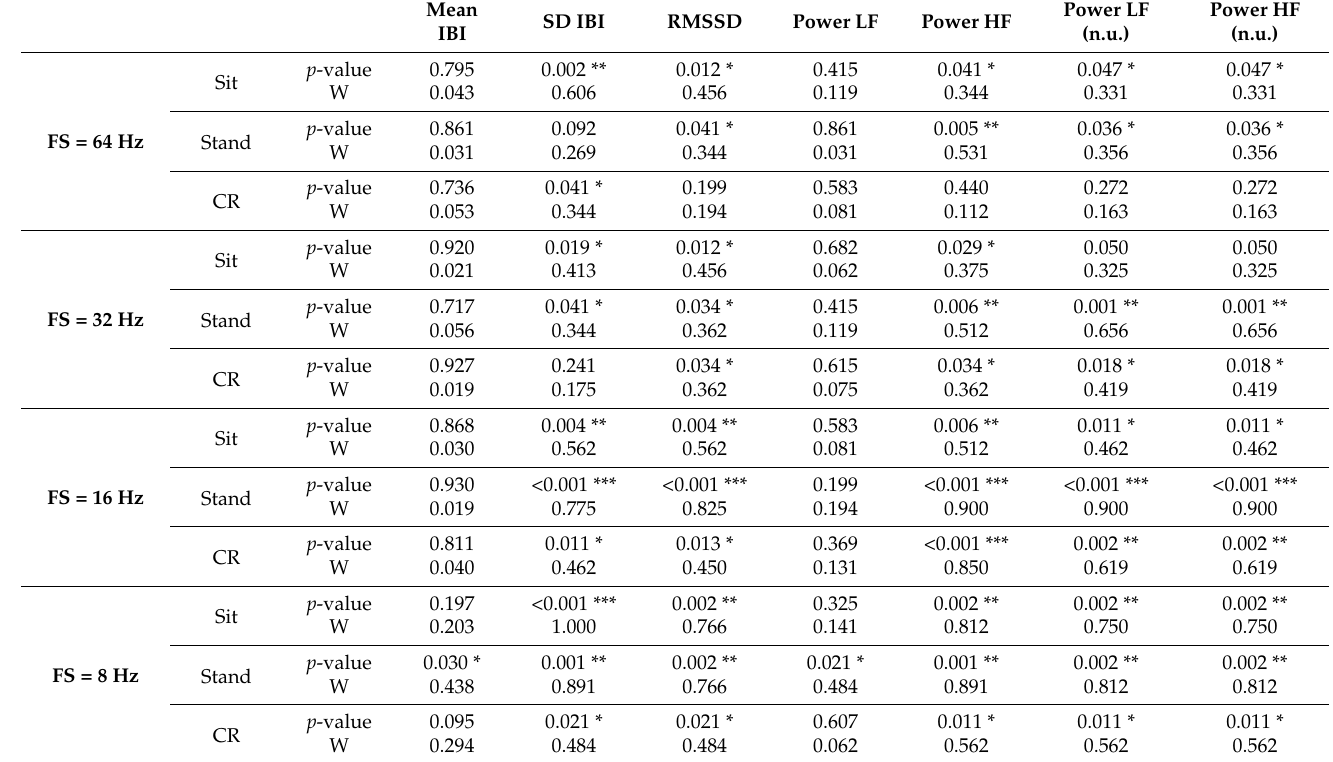
Table 6. Comparison of the HRV indices estimated with the different PPG interpolation techniques. p -values and effect sizes (Kendall’s W ) of Friedman’s tests conducted on the AEs of the considered HRV indices for each PPG sampling frequency (FS) and protocol phase. Test degrees of freedom were (3, 21) for all the FS except 8 Hz (2, 14) due to the inapplicability of REG at this